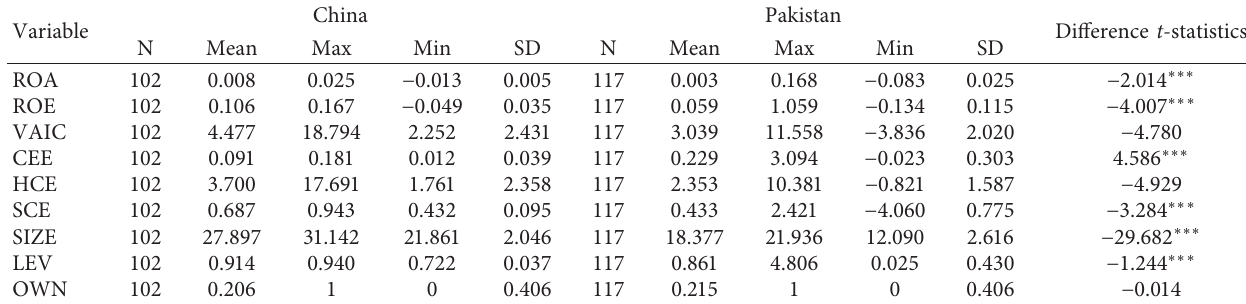
Table 2: Descriptive statistics of banks in China and Pakistan.